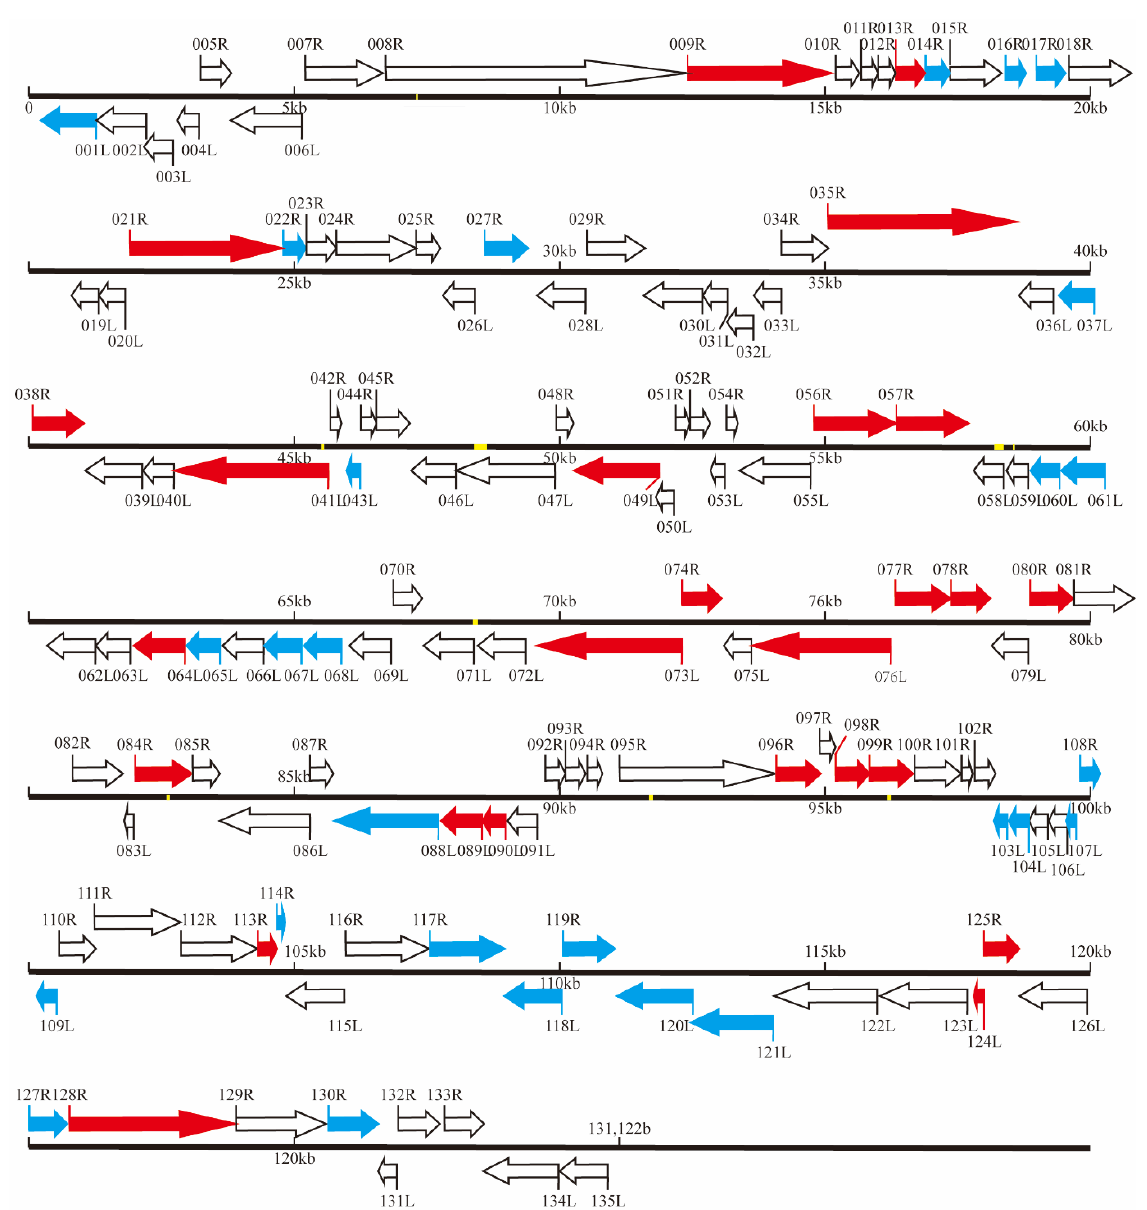
Figure 4. Liner schematic organization of ZH ‐ 06/20 genome. The 26 common core genes in iridovirus, 27 ZH ‐ 06/20 specific genes and ZH ‐ 06/20 tandem repeat areas are indicated in red, blue, and yellow, respectively. Generally, ZH ‐ 06/20 is composed of 131,122 nucleotides with 135 ORFs and 27 unique genes are never found in other iridoviruses, except for SDDV.